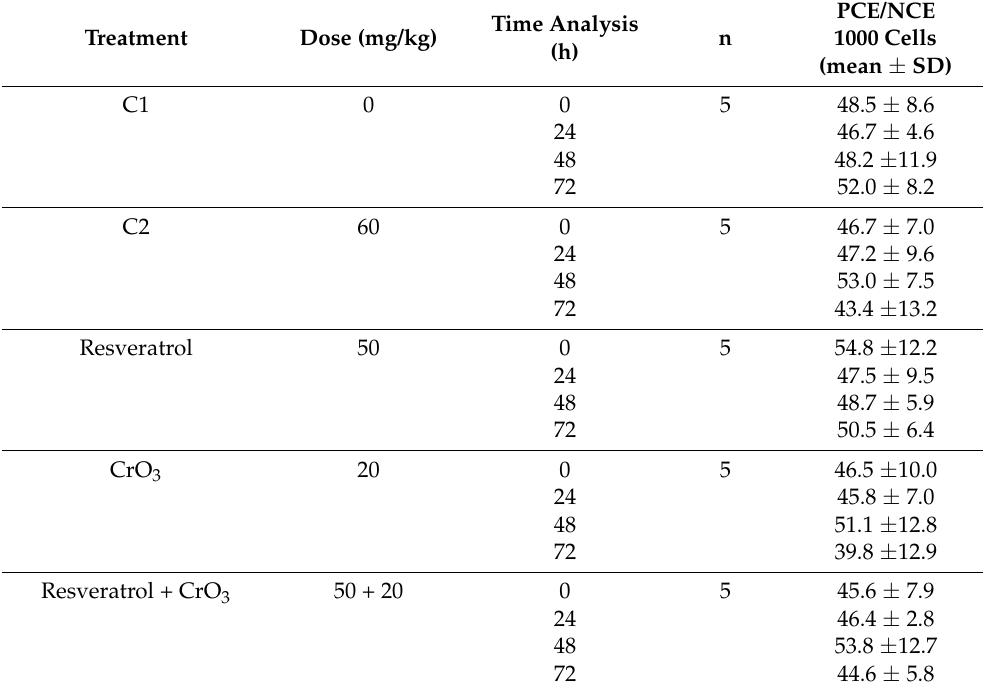
Table 1. PCE/NCE ratio in peripheral blood of mice treated with resveratrol and CrO 3 .